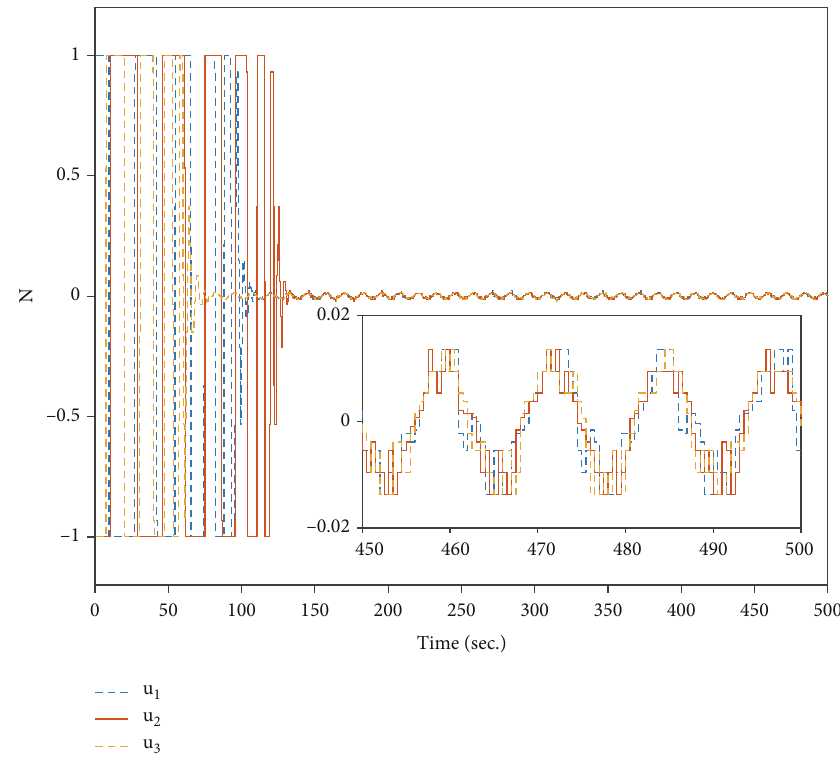
Figure 6: Response curves of quantized control